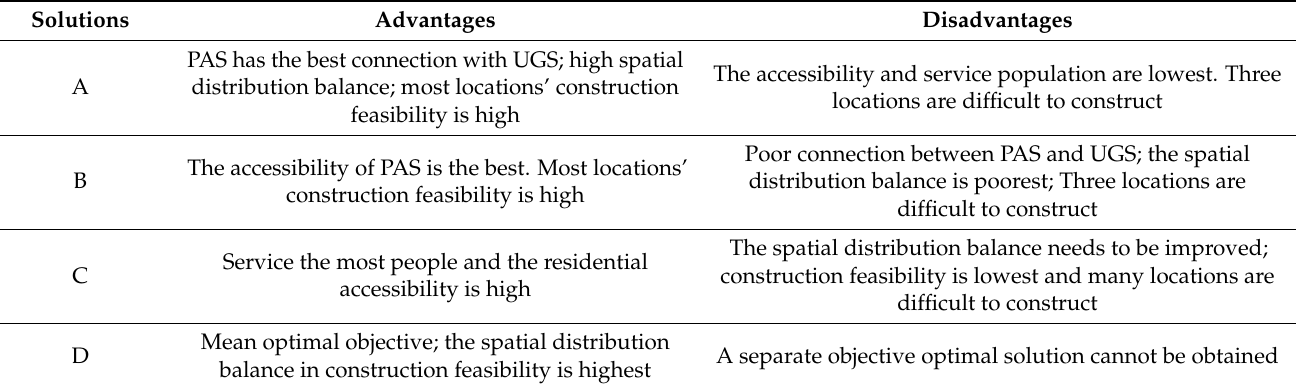
Table 3. Comprehensive evaluation of the